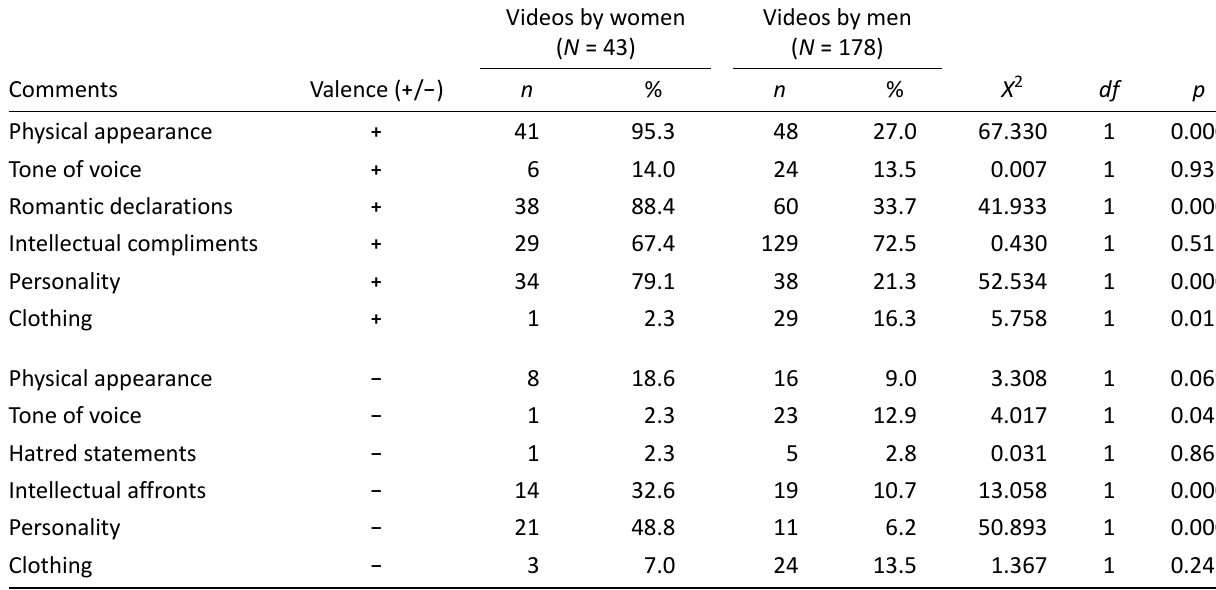
Table 5. Popular science videos in which positive and negative personal comments are posted, differentiated by the gender of the YouTuber (with respect to the total 221